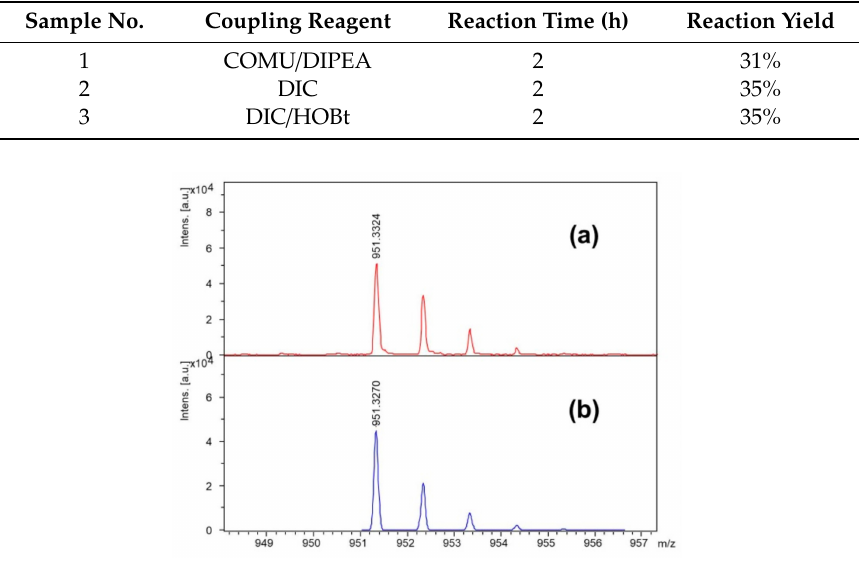
Figure 2. ( a ) High resolution matrix-assisted laser desorption / ionization time-of-flight (MALDI-TOF) mass spectrum of the synthesized IAA-Leu-Tyr-Ahx-Lys(biotin)-NH 2 ; sodium adduct was observed as an ion at m / z 951.3324. ( b ) Theoretical high resolution mass spectrum representing ion C 39 H 61 IN 8 O 8 SNa +